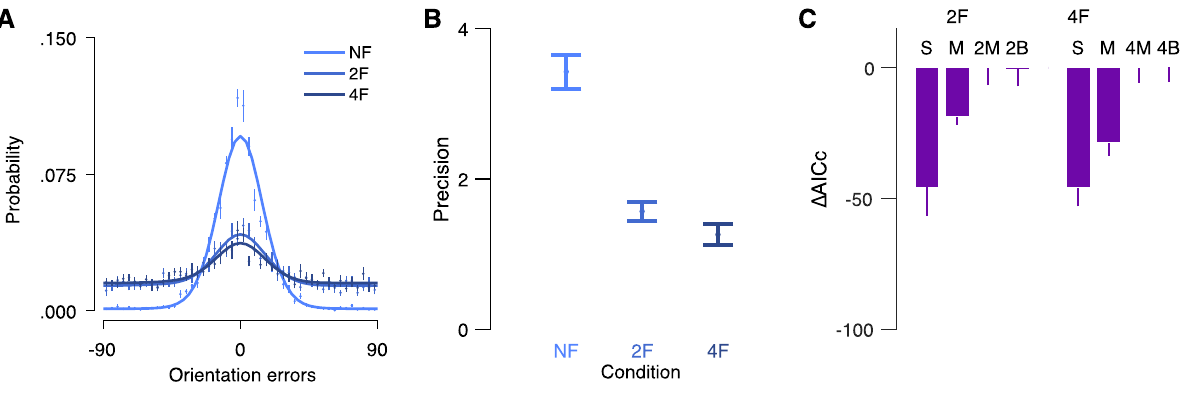
Figure 2. Error distribution and model comparison of “Experiment 1”. ( A ) Mean errors for each of the three crowding conditions. Solid lines are the best performing model in each crowding condition. ( B ) Mean precision (inversed SD in radiance) of the errors in each crowding condition. ( C ) Mean AICcs for each model subtracted from the AICc of the best performing model (AICc 2M – AICc i and AICc 4M – AICc i , in the two-flanker and four- flanker respectively) in each crowded condition. UC uncrowded, 2F two-flanker and 4F four-flanker. Models: S standard mixture, M misreport, 2M two-misreport, 2B two-misreport with bias, 4M four-misreport, 4B four- misreport with bias. Error bars are within subject ± 1 SEM.